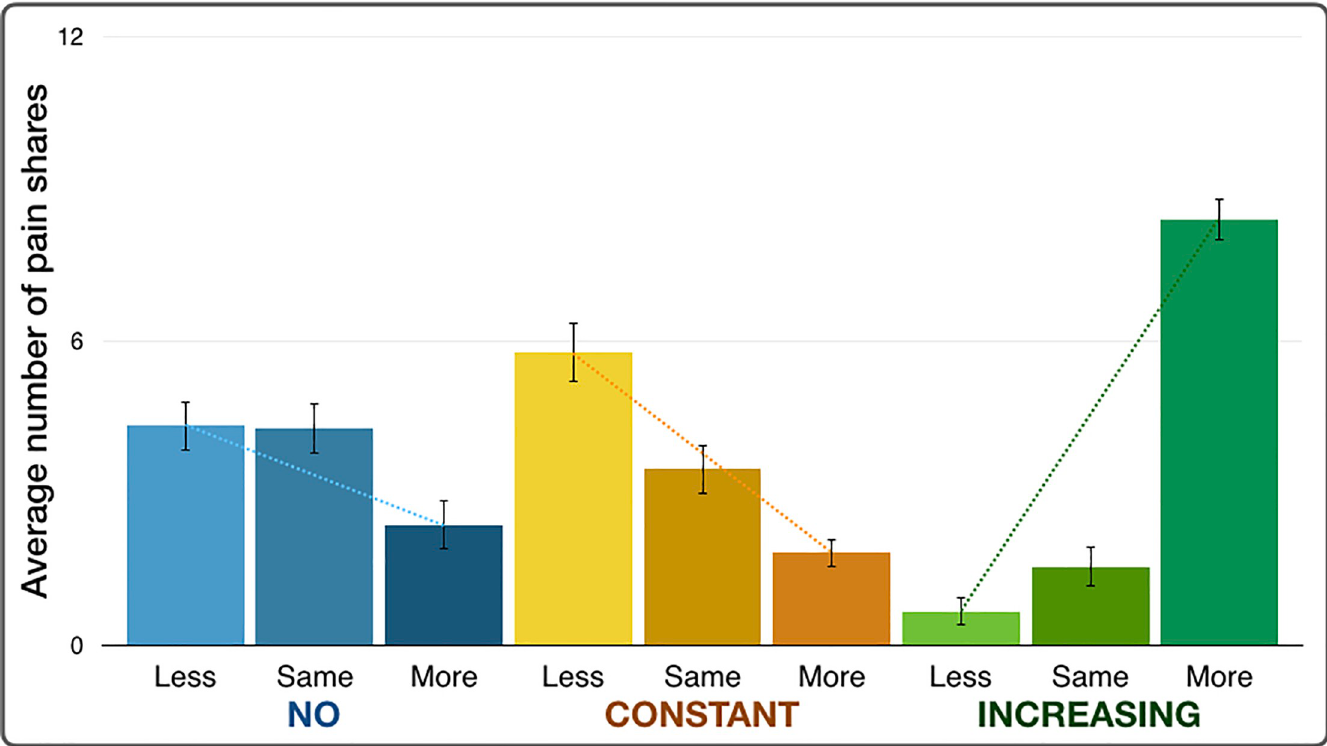
Fig 3. Average number of shared pain stimulations categorized by altruistic choices shows that during the CONSTANT session, there was a trend for sharing less or the same amount of pain. During the INCREASING session, there was a trend for sharing more pain.